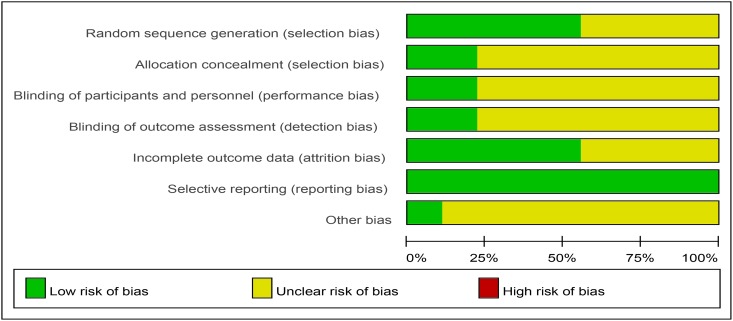
Risk of bias graph.